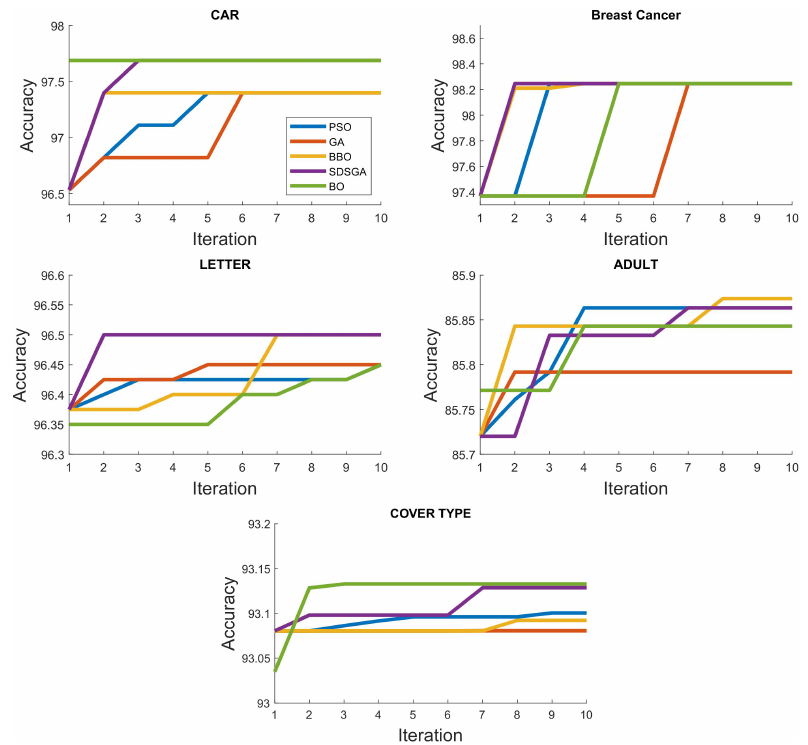
Figure 7. Prediction accuracy for the different algorithms under the different UCI